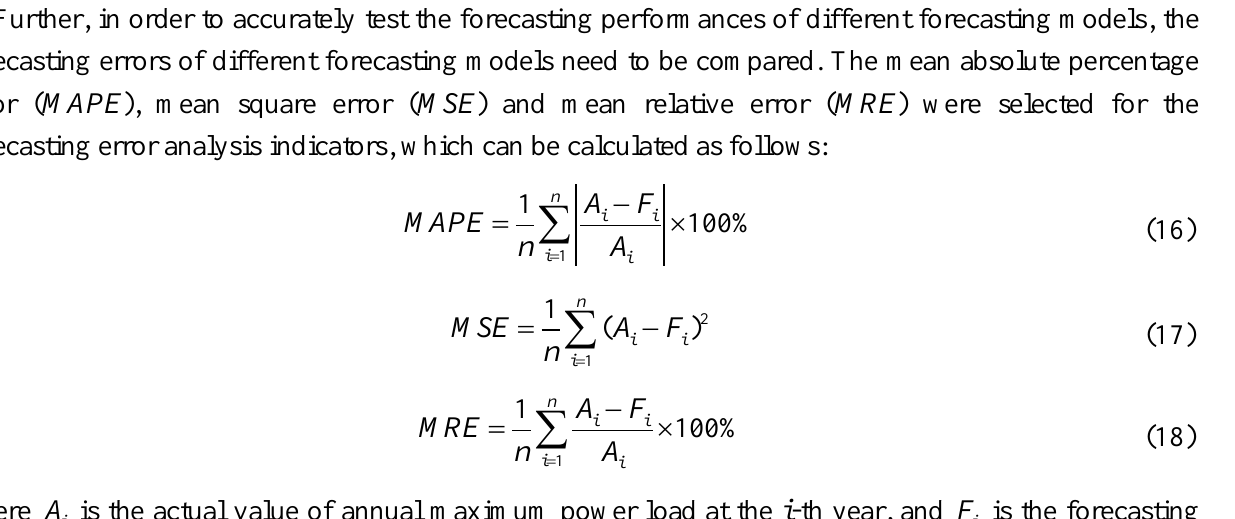
Figure 6. Comparisons of forecasting values of different models and actual power